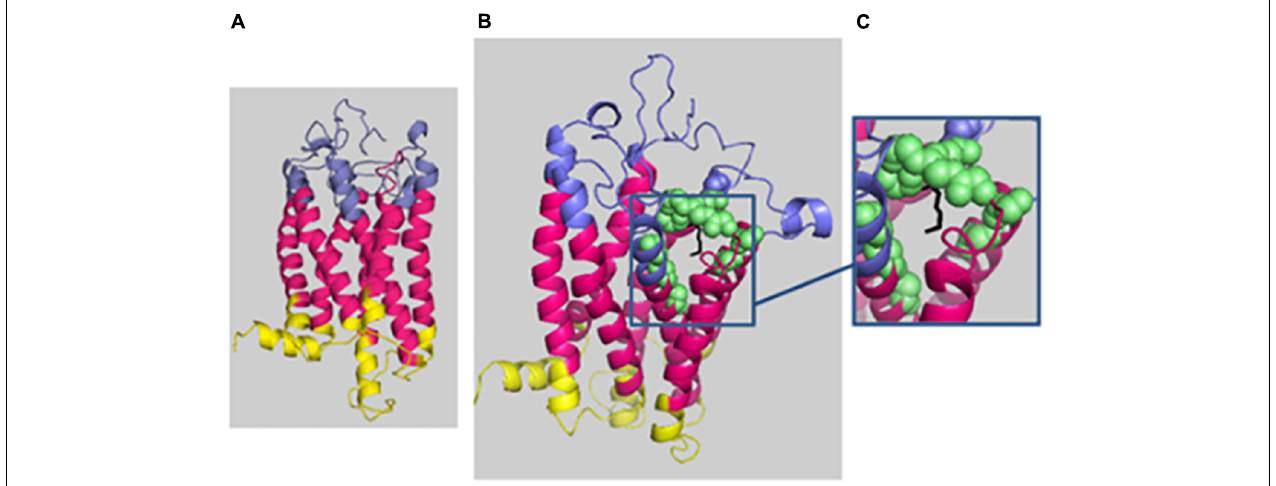
FIGURE 2 | Phyre2 prediction of the deleterious effect of p.(Lys205del) on the 3D protein structure. The protein backbone is shown in cartoon representation, with the extracellular domain (EC) in blue, the transmembrane domain (TM) in hot pink, and the intracellular domain in yellow. (A) Mutated protein prediction. (B) WT protein prediction. (C) Zoomed-in image of residue 205 (localized in EC3) shown as black sticks, and the residue interactions around 4 Å are shown as green spheres: 131N and 136T (EC 2); 193T, 194E, 195T, 204E, 206E, 207F, and 223Y (EC3); and 140Y (TM3) and 227I (TM5). The figure was produced with Pymol.